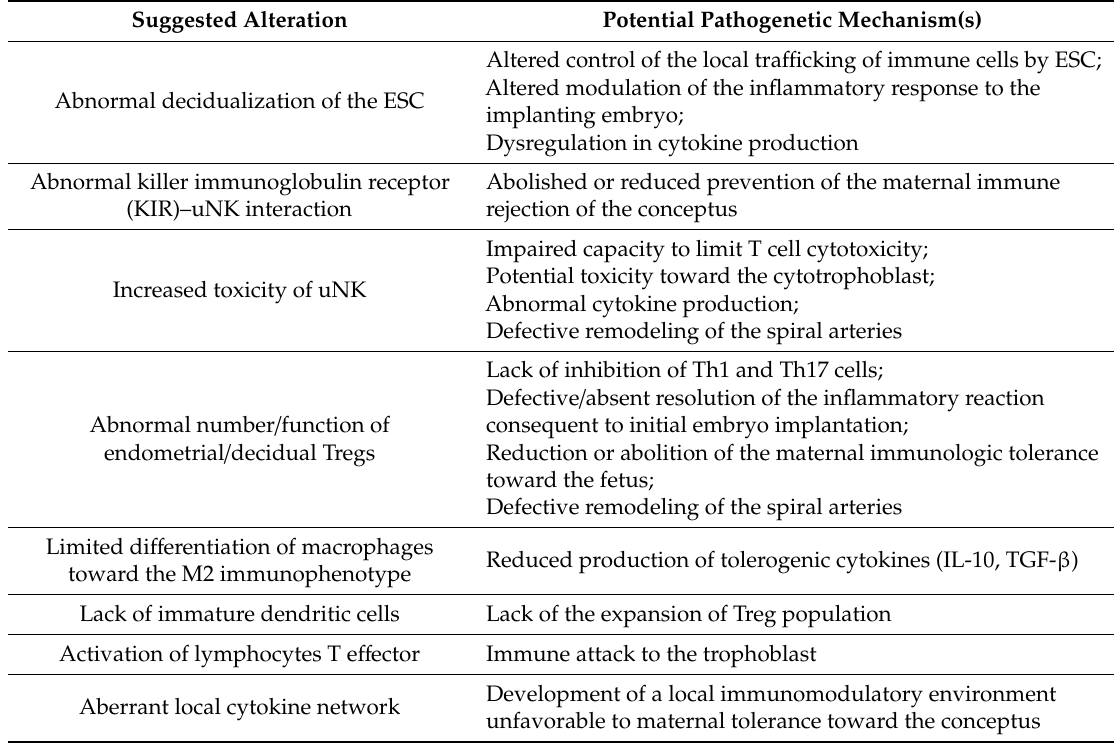
Table 6. Summary of the suggested major immunologic alterations in the endometrium and potential pathogenetic mechanisms leading to